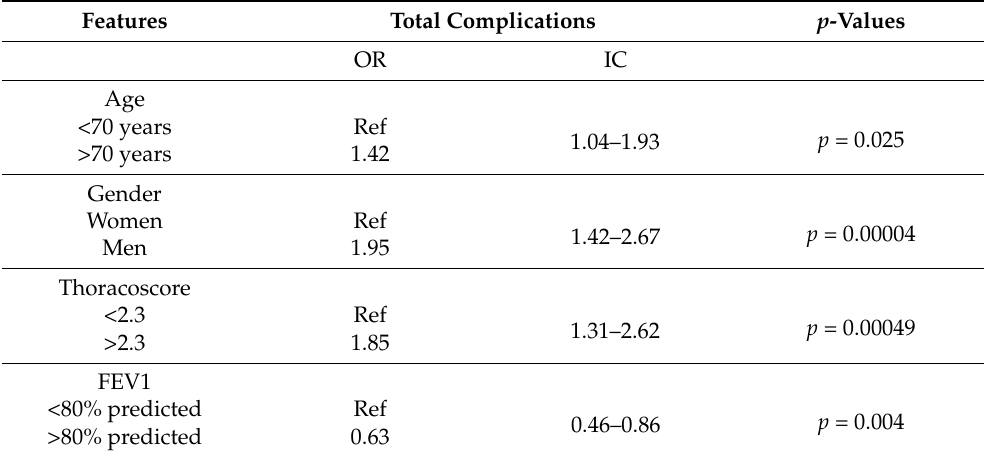
Table 7. Factors independently associated with the occurrence of complications. OR: Odd Ratio, CI: 95% Confidence Interval. The cut-off of 2.3 for Thoracoscore represents 75th percentile.